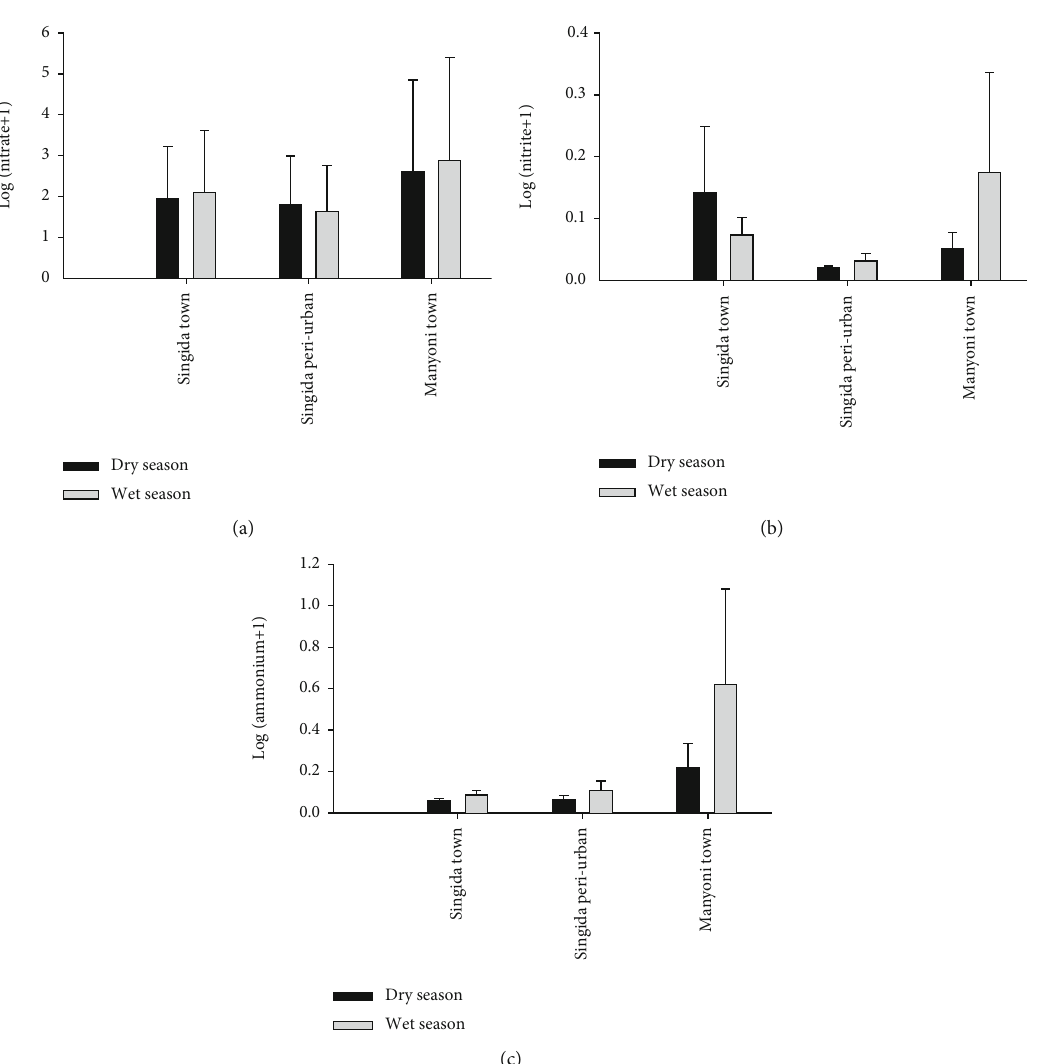
Figure 3: The logarithmic distribution of (a) nitrates (ppm), (b) nitrite (ppb), and (c) ammonium (ppb) in shallow wells of Singida and Manyoni towns and peri-urban areas during the dry and wet